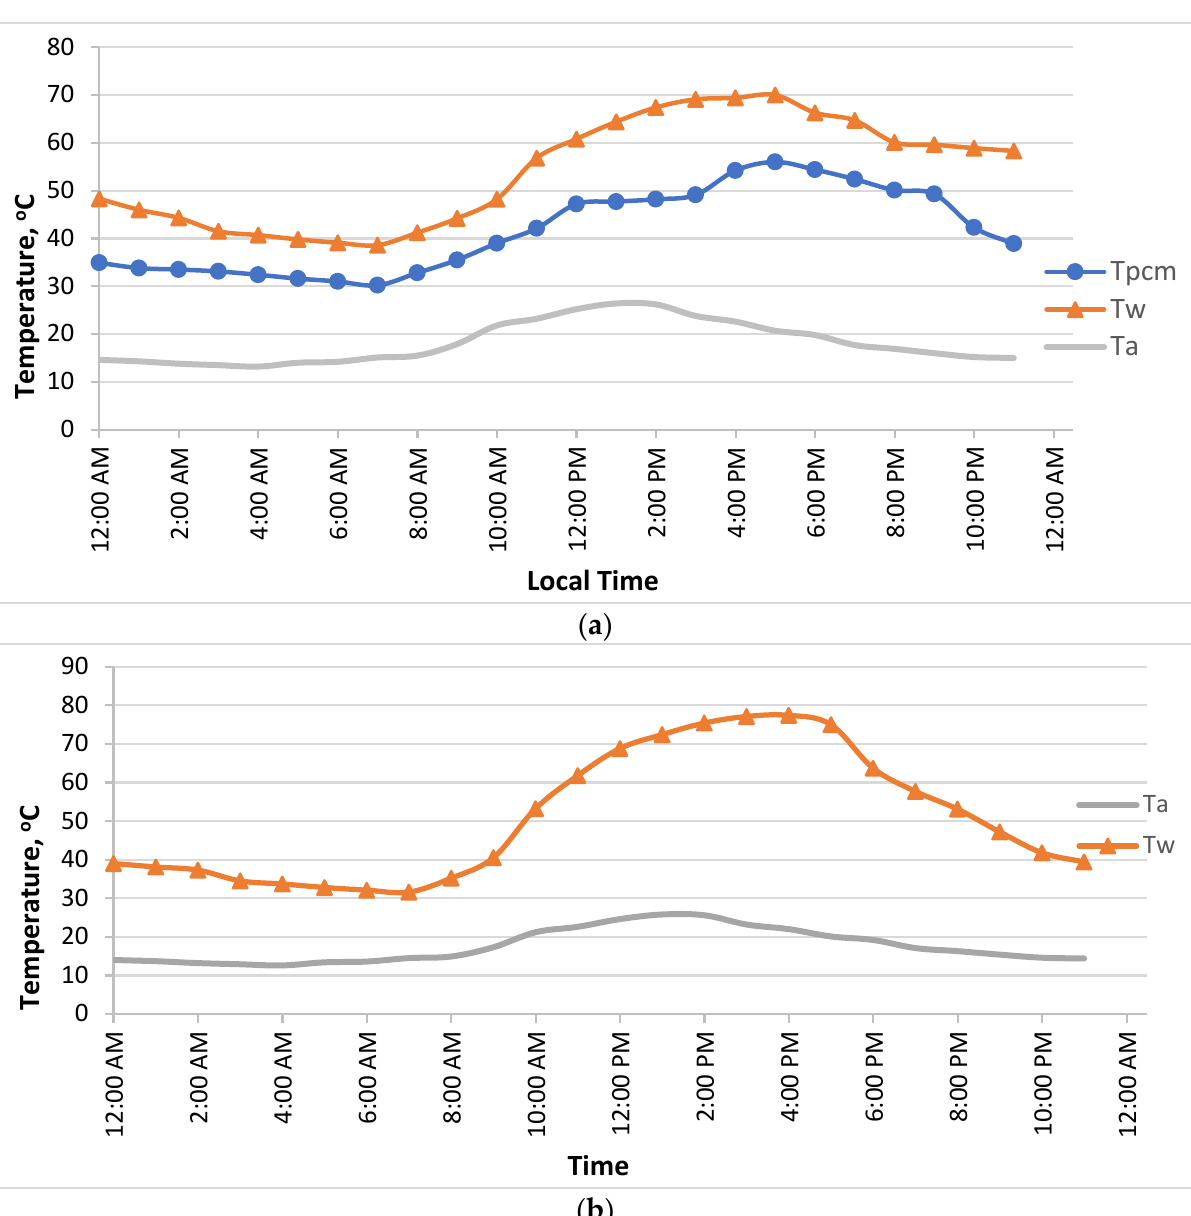
Figure 5. Temperature distribution of the system through December 2021: ( a ) using paraffin as PCM; ( b ) without PCM.